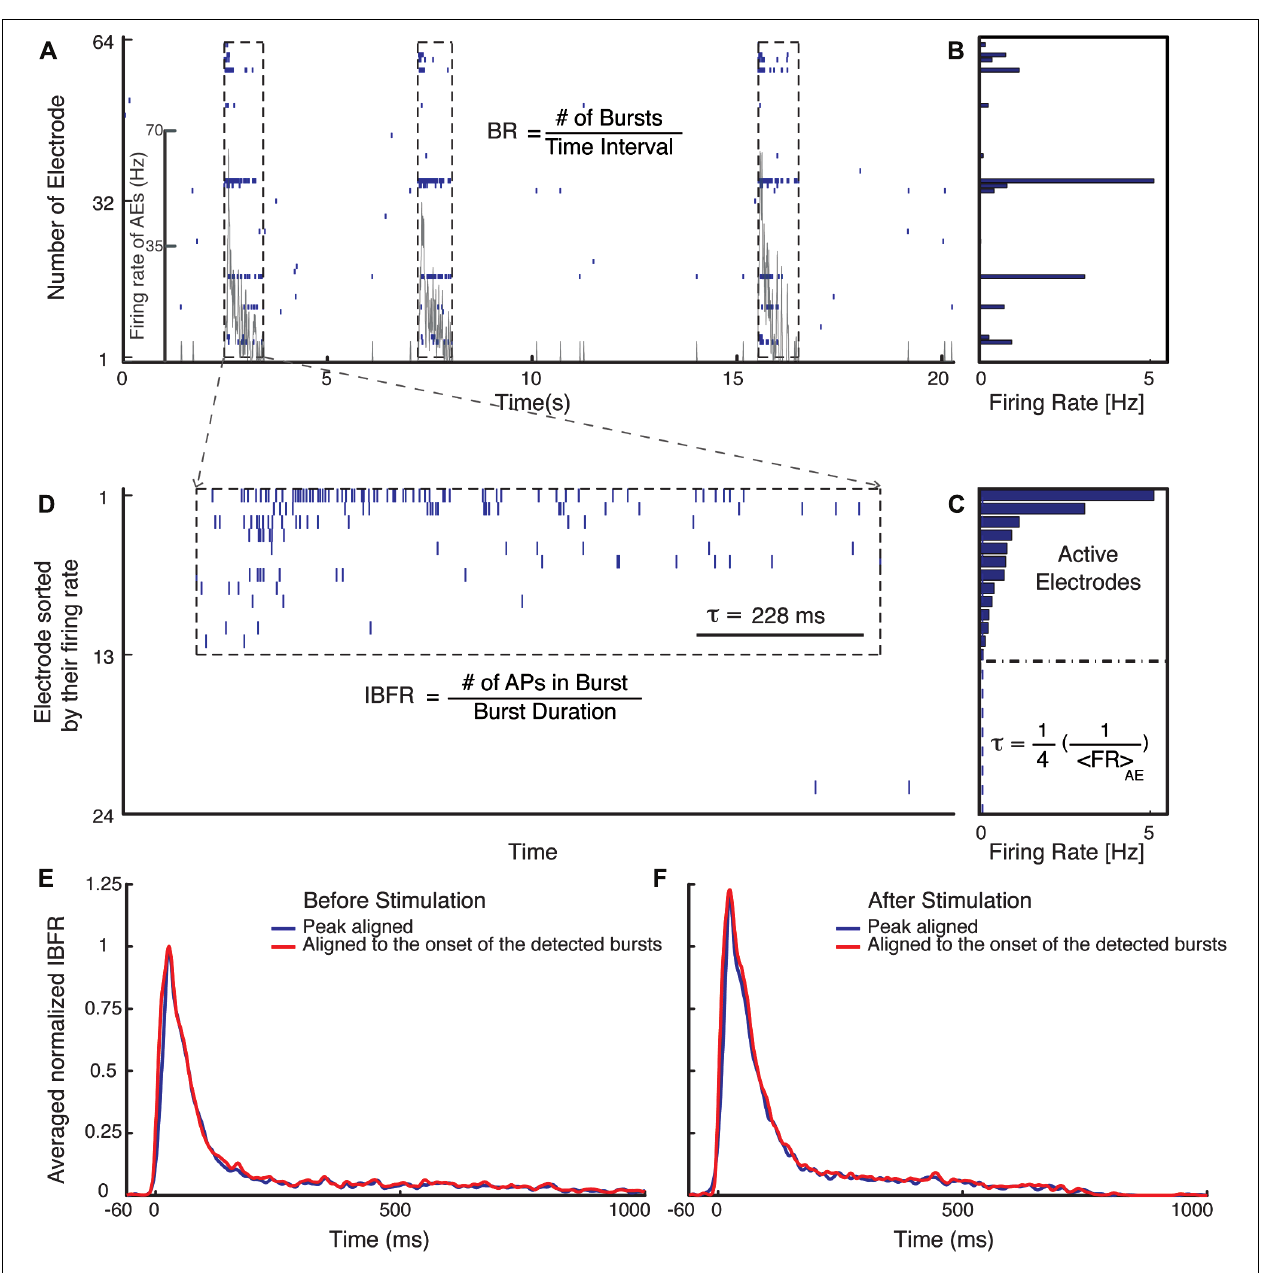
FIGURE 1 | Burst detection algorithm. (A) Typical electrical activity of a culture recorded via all 60 channels and the corresponding FR of AEs (gray line). In (B) , the average spontaneous FRs over 300 s of the corresponding electrodes are shown. The graph (C) shows the rank ordered FRs of all electrodes. Selection of the active electrodes (AE), electrodes with average FR larger than 0.1 Hz is illustrated. The threshold for detecting a burst is defined as 1/4 of the inverse average FR of all AE.